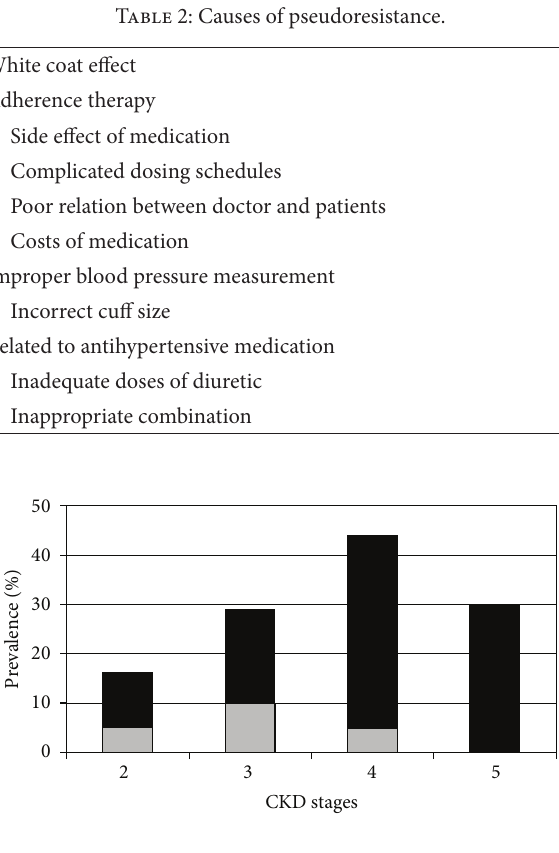
Figure 1: Prevalence of true resistance (black bar) and pseudoresis- tance (gray bar) in CKD stages [17].